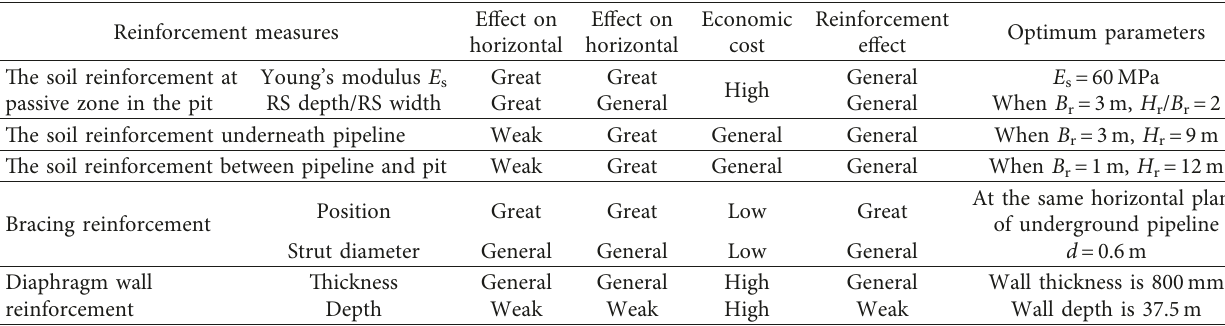
Figure 15: The diagrammatic sketch of pit with setting the strut. (a) The planar graph of set strut. (b) The profile of set strut. Table 3: Summary of pipeline reinforcement